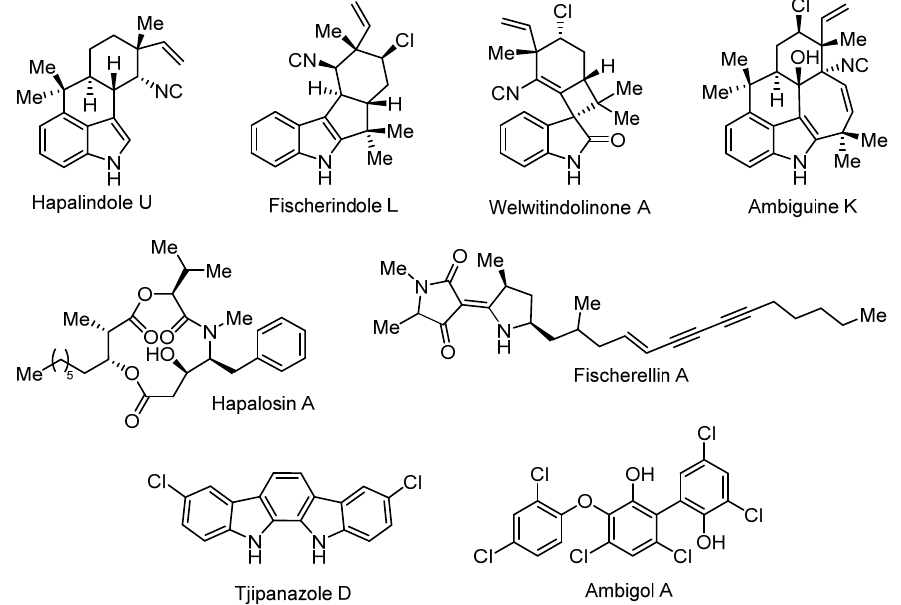
Figure 5. Representative chemical structures from Symphyonema bifilamentata sp. nov. 97.28 and various strains of Fischerella .